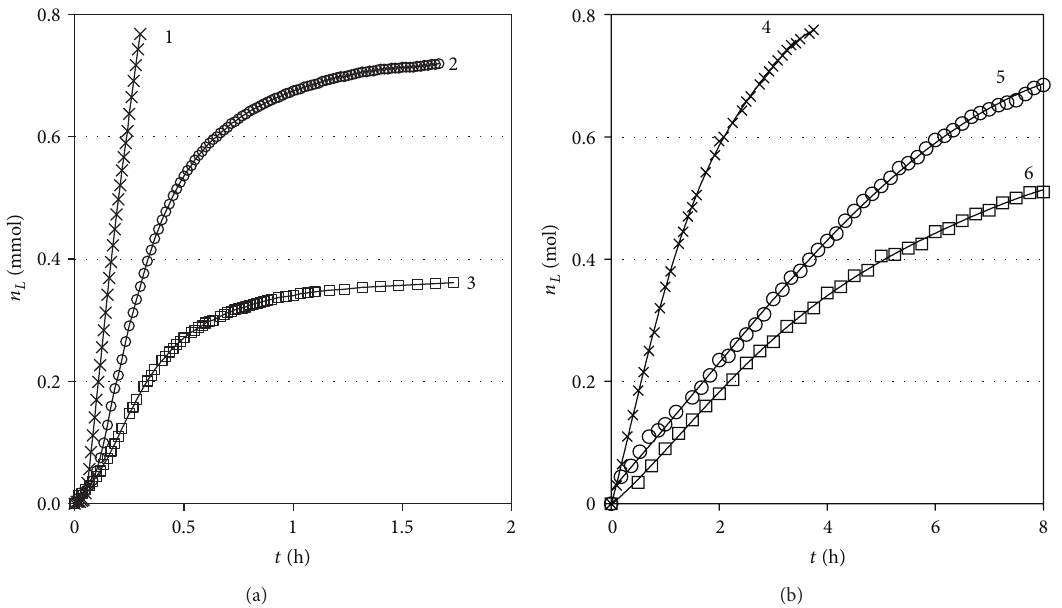
Figure5:Solventinflux 𝑛 𝐿 asafunctionofelapsedtime 𝑡 dependencesforthethreestudiedsoluteconcentrations:(a)constantvolumeregime: (1) 0.5 M; (2) 0.2 M; (3) 0.1M ( 𝑛 𝐿 is expressed in millimoles); (b) variable volume regime: (4) 0.5 M; (5) 0.2M; (6) 0.1M ( 𝑛 𝐿 is expressed in